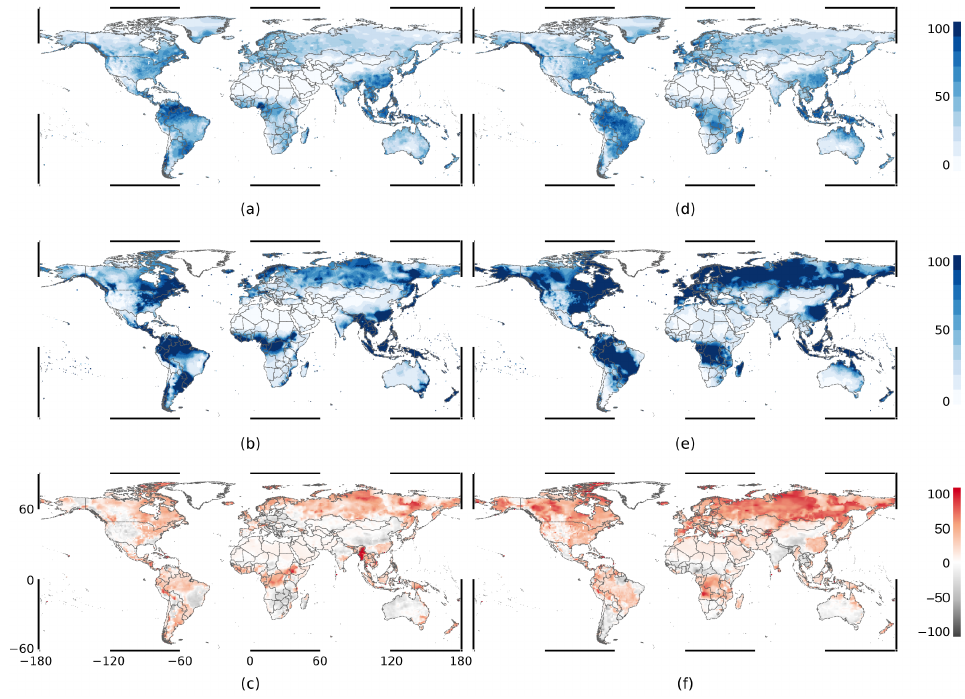
Figure 7. Global mean relative soil moisture (%) for June (left) and December (right) 2000 CE from NCEP CPC (top), from the SPLASH model (middle), and showing the difference between SPLASH and NCEP CPC (bottom). (a) NCEP CPC June 2000; (b) SPLASH June 2000; (c) difference between SPLASH and NCEP CPC June 2000; (d) NCEP CPC December 2000; (e) SPLASH December 2000; and (f) difference between SPLASH and NCEP CPC December 2000. Color bars on the right are linear interpolations of results in units of relative soil moisture (%). The relative soil moisture is based on the total bucket size (i.e., 760mm for NCEP CPC and 150mm for SPLASH). Differences in red indicate higher SPLASH model